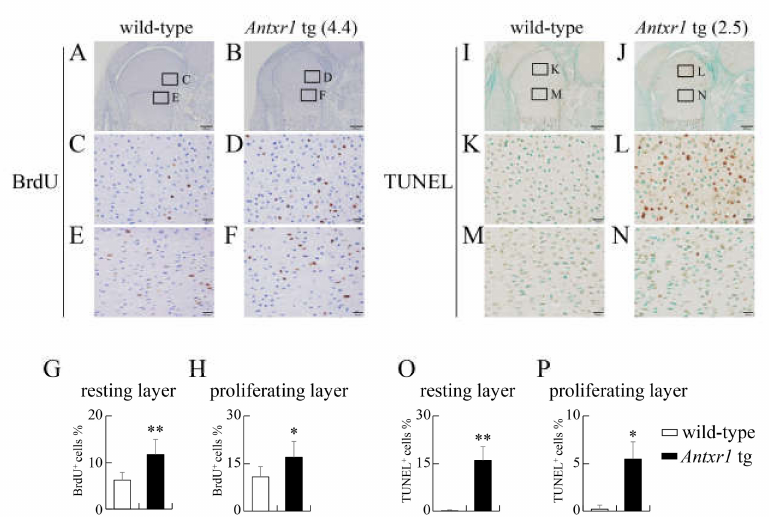
Figure 10. Proliferation and apoptosis in femurs of wild-type and Antxr1 tg embryos at E18.5: ( A – H ) BrdU staining ( A – F ) and the frequencies of BrdU-positive chondrocytes in the resting ( A – D , G ) and proliferating ( A , B , E , F , H ) layers of wild-type ( A , C , E ) and Antxr1 tg ( B , D , F ) F 0 embryos. ( I – P ) TUNEL staining ( I – N ) and the frequencies of TUNEL-positive chondrocytes in the resting ( I , J , K , L , O ) and proliferating ( I , J , M , N , P ) layers in wild-type ( I , K , M ) and Antxr1 tg ( J , L , N ) F 0 embryos at E18.5. The boxed regions in A , B , I , and J are magnified in C and E , in D and F , in K and M , and in L and N , respectively. The expression levels in tg embryos are shown in parentheses. Scale bars: 200 µ m ( A , B , I , J ) and 20 µ m ( C – F , K – N ). The number of mice analyzed: BrdU staining, wild-type: 6, Antxr1 tg: 4; Figure 7Q–T. Versus wild-type, * p < 0.05, ** p <